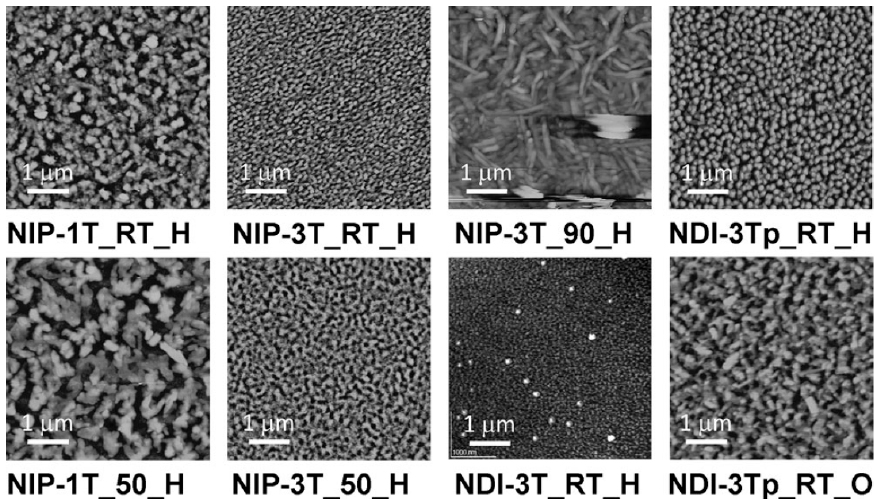
Figure 14. AFM images of vapor-deposited thin films of NDI-3T , NDI-3Tp and NIP-3T . Reproduced with permission from Chem. Eur. J . 2013 , 19 , 12458–12467. Copyright© 2013 WILEY-VCH Verlag GmbH & Co. KGaA, Weinheim, Germany [29].